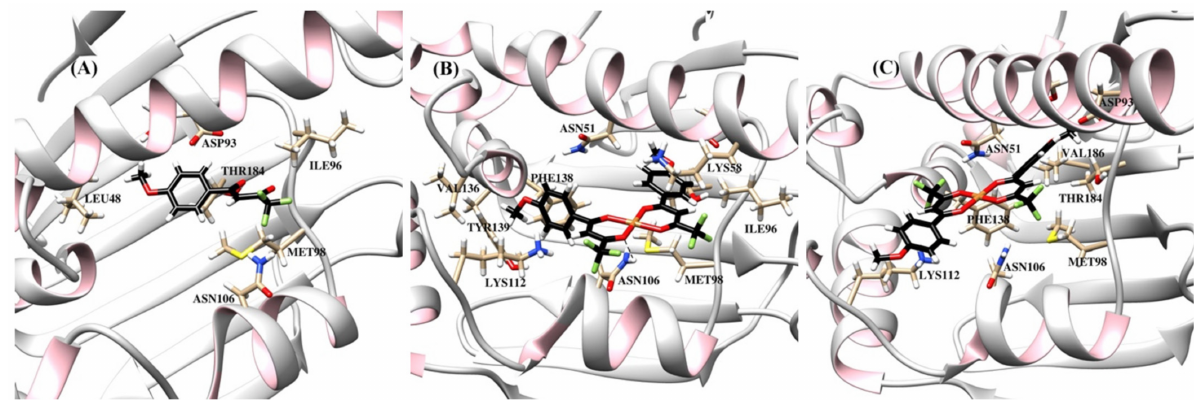
Figure 8. Ribbon representation of the Hsp90 protein with bound compounds H L1 ( A ), cis -[Cu( L1 ) 2 ] ( B ), and trans -[Cu( L1 ) 2 ] ( C ). Binding site showing selected amino acids and hydrogen bonding (dashed line) between the compound cis -[Cu( L1 ) 2 ] and Asn106.